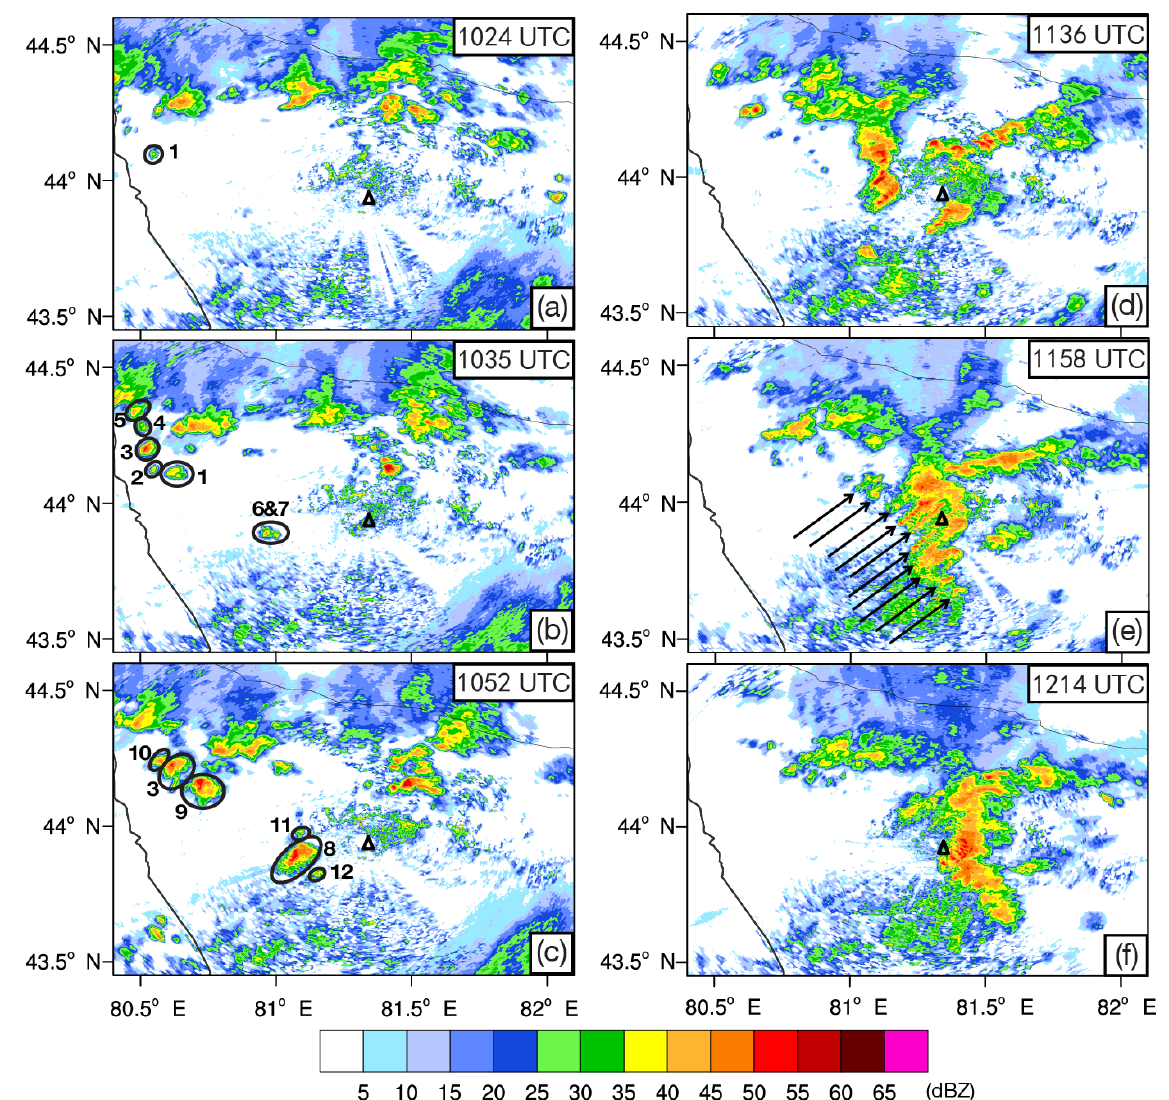
Figure 3. ( a – f ) Composite radar reflectivity (shading, units: dBZ) observed by Yining radar station (indicated by black triangle) on 17 June 2016. The specific time is shown in the upper right corner of each panel. The locations of the convection initiated in the central study area are indicated by black ellipses or circles with numbers. The black dots indicate the locations of the ground-based automatic weather stations (S1, S2, and S3) mentioned in Figure 4.